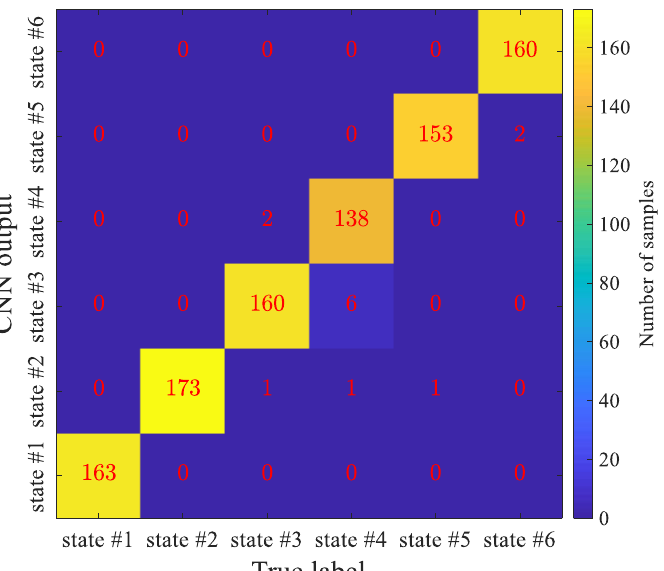
Figure 20. Confusion matrix.